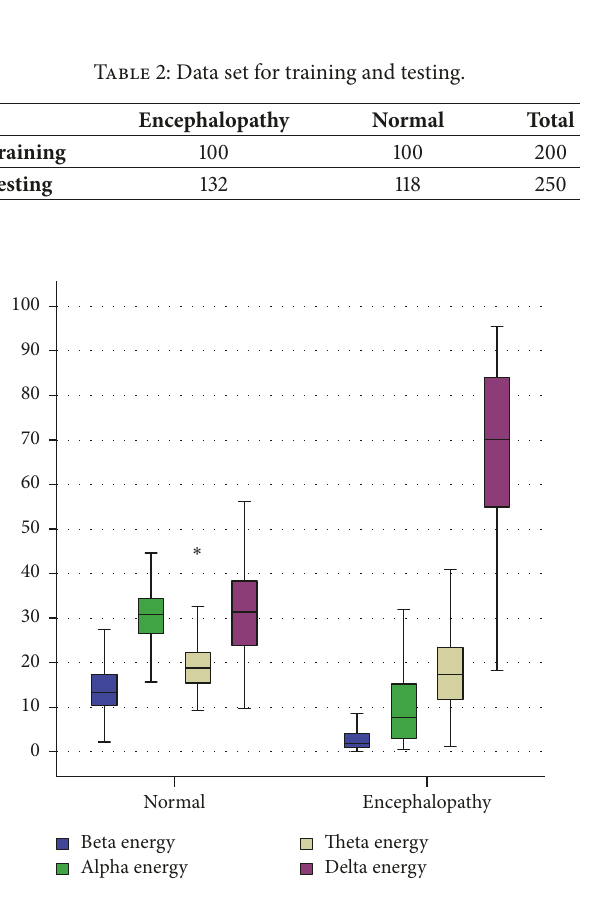
Figure 6: Distribution of EEG subband energies in encephalopathy and healthy groups.